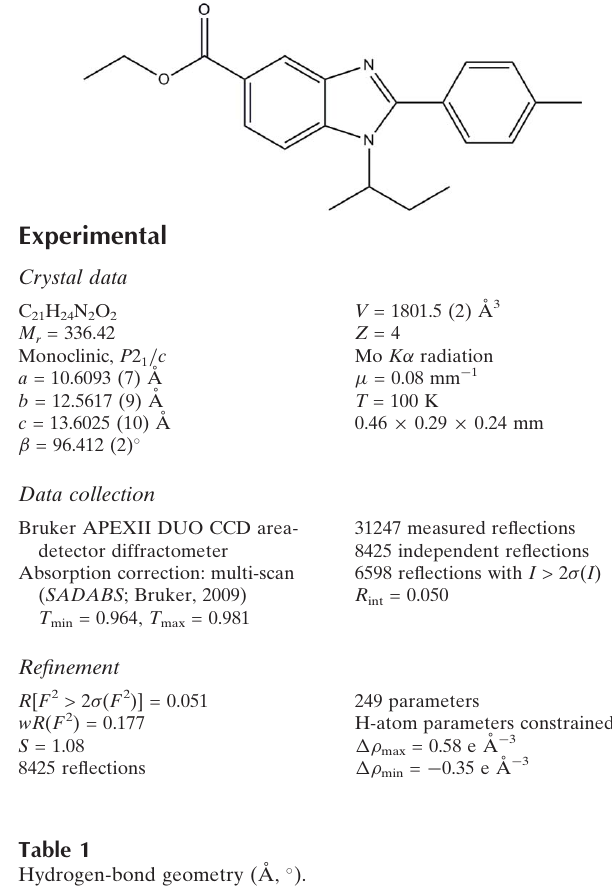
Hydrogen-bond geometry (A˚ , (cid:2)